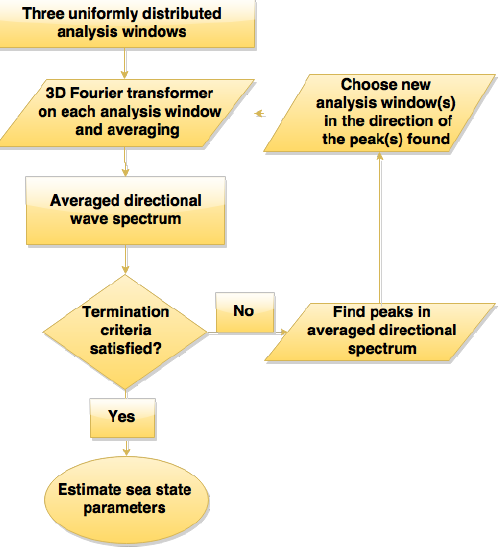
Figure 5. Adaptive Recursive Positioning Method (ARPM) flowchart.